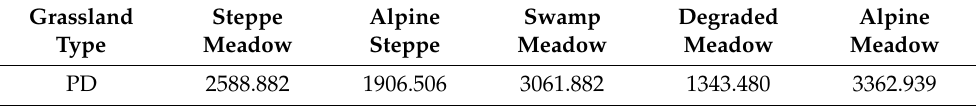
Table 1. The patch density of five alpine grassland types.